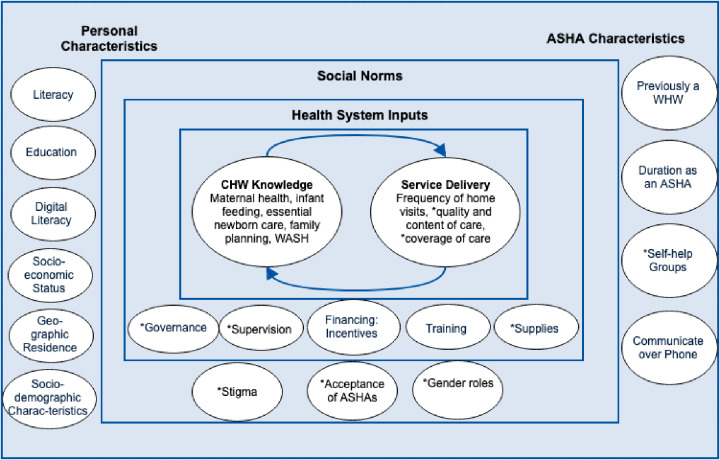
Conceptual Framework of determinants relating to knowledge of ASHAs.